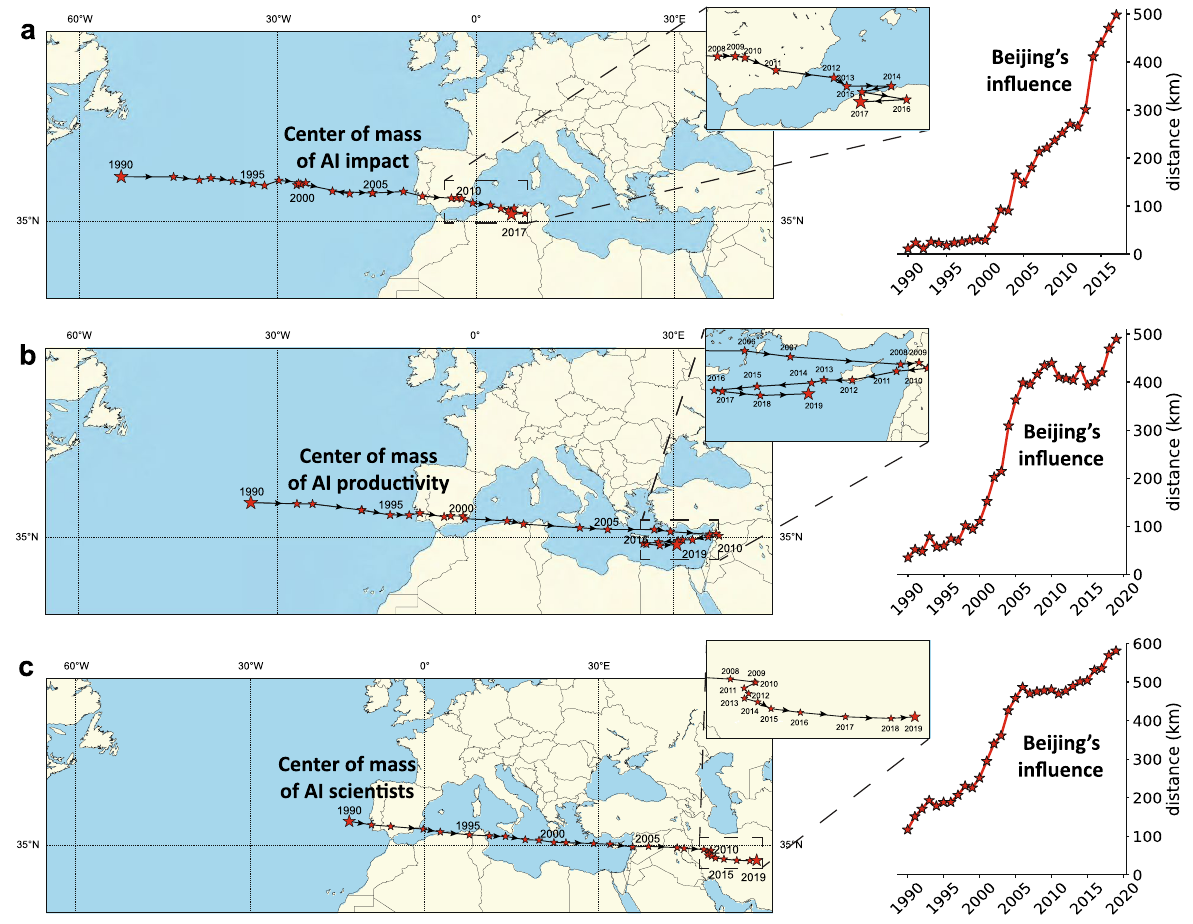
Figure 4. Trajectory of the centers of mass of AI research. ( a ) Left panel: Trajectory of the center of mass of AI impact from 1990 to 2017 (figure generated using the Matplotlib Basemap Toolkit; https:// matpl otlib. org/ basem ap/); Right panel: Beijing’s influence, measured each year as the distance (in kilometers) between the center of mass that accounts for all cities (including Beijing) and the one that accounts for all cities except Beijing. ( b , c ) are similar to ( a ) but for AI productivity and AI scientists, respectively, from 1990 to